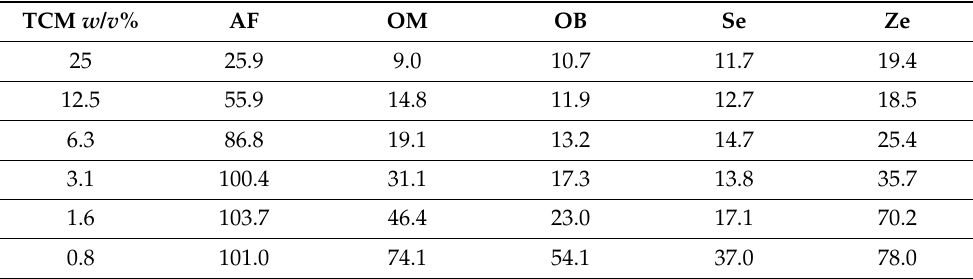
Table 2. Proliferation behavior in % compared to untreated L929 fibroblasts after stimulation with different concentrations of toothpaste-conditioned medium